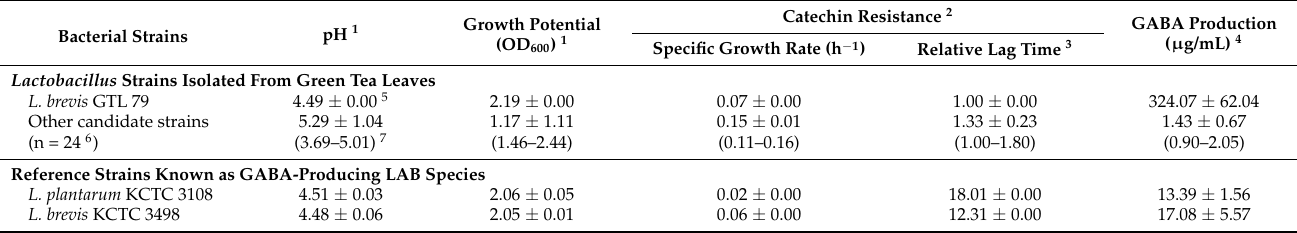
Table 1. Selection of Lactobacillus strain for lactic acid fermentation of green tea based on acid production, growth, catechin resistance, and GABA production